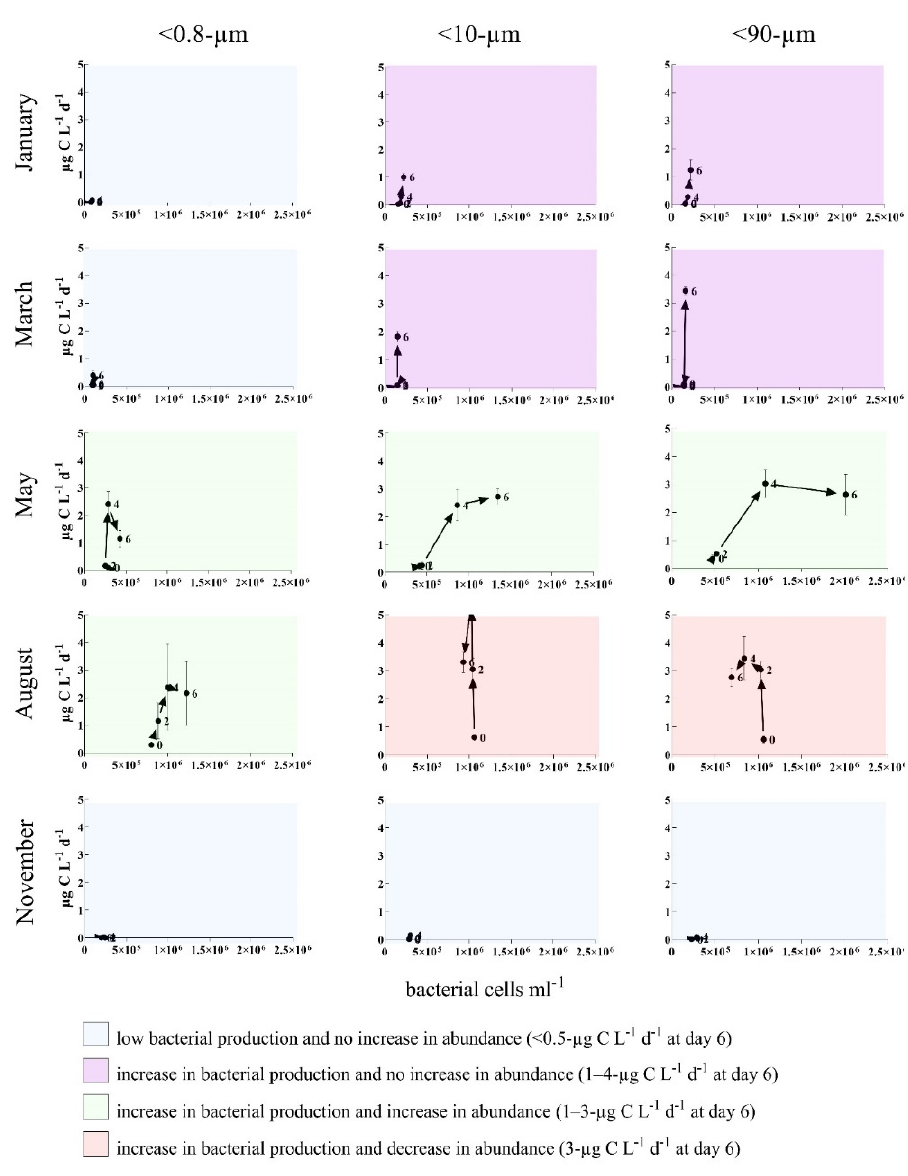
Figure 3. Plots of bacterial production (BP) shown in relation to bacterial abundance (BA) in the different fractions at 0, 2, 4 and 6 days of incubation. The different background colors indicate different groups based on a combination of BP and BA. Plots with a blue background indicate low BP and no increase in BA (<0.5- µ g C L − 1 d − 1 at day 6). Purple indicates an increase in BP, but no increase in BA (1–4- µ g C L − 1 d − 1 at day 6). Green visualizes experiments with an increase in BP and increase in BA (1–3- µ g C L − 1 d − 1 at day 6), while red indicates an increase in BP and decrease in BA (3- µ g C L − 1 d − 1 at day